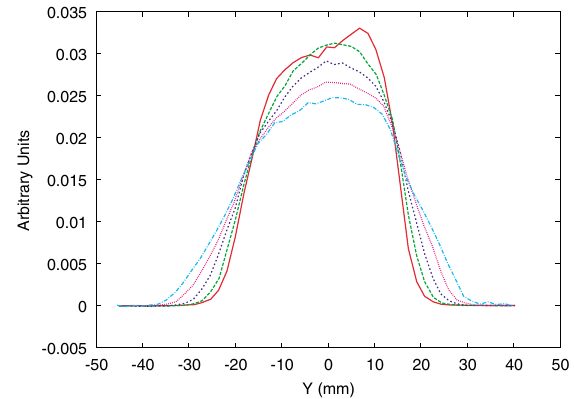
FIG. 15. (Color) Experimentally measured vertical beam pro- files for tunes in the range of (cid:3) (cid:4) where the profile widths increase as (cid:4)